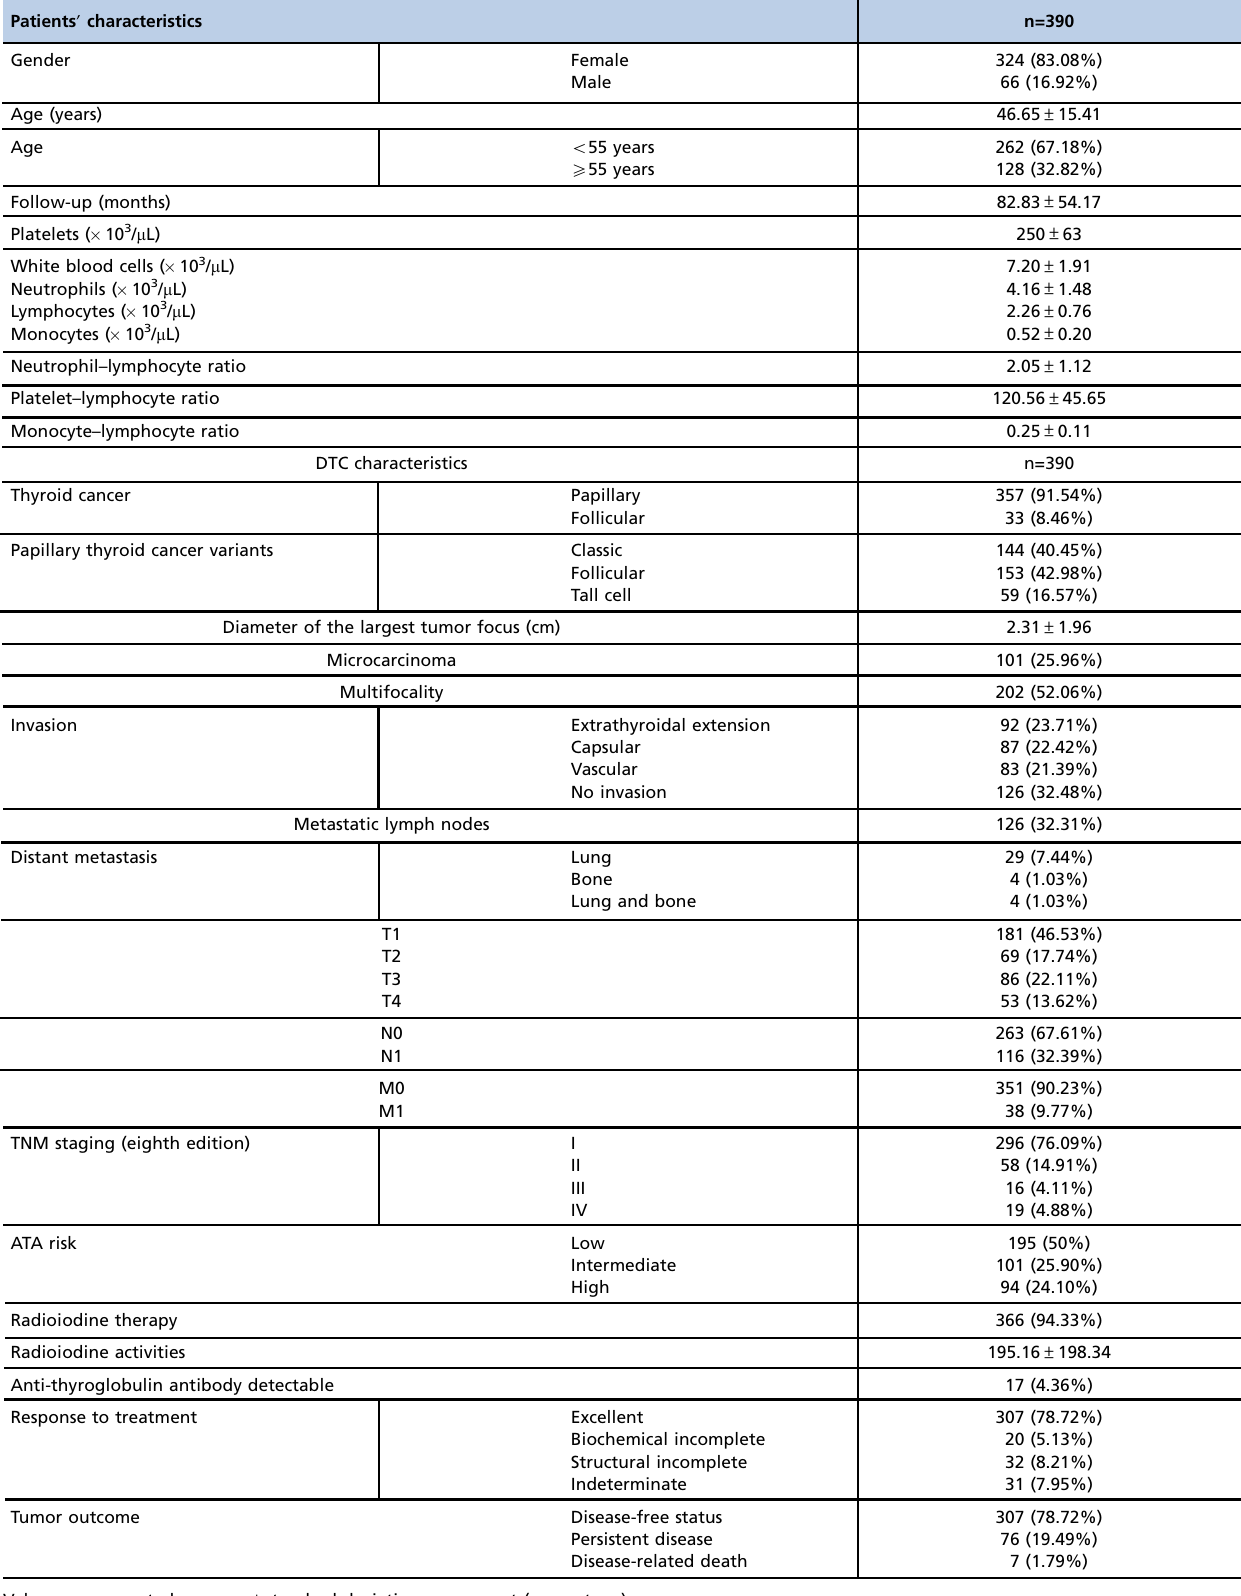
Table 1 - Baseline and histopathological characteristics and outcomes of patients with differentiated thyroid